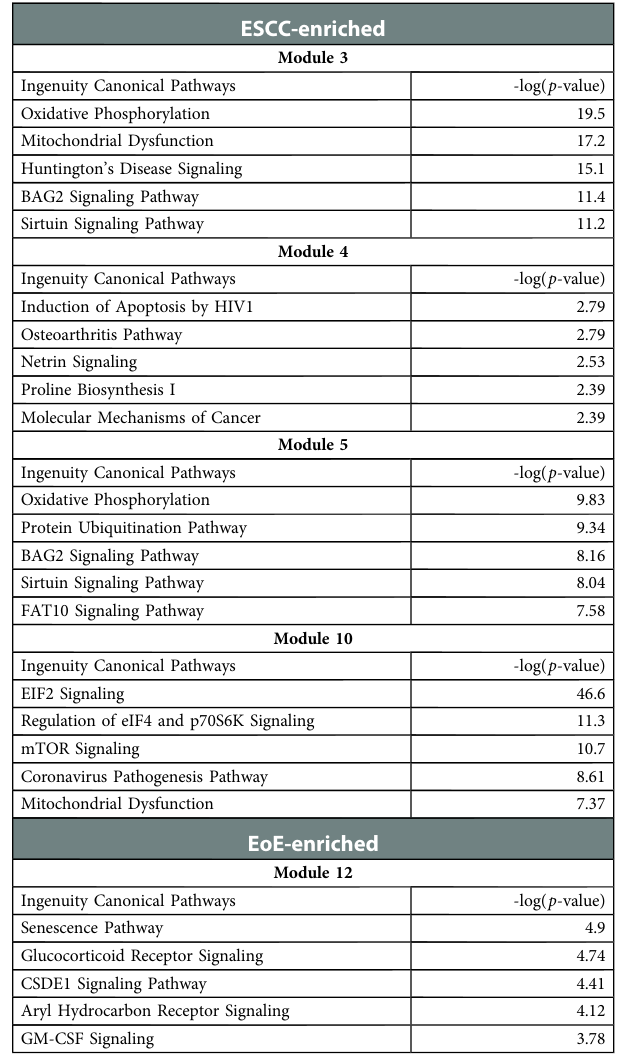
TABLE 1 Gene modules predicted to be associated with epithelial populations that are enriched in mice with esophageal squamous cell carcinoma (ESCC) or eosinophilic esophagitis